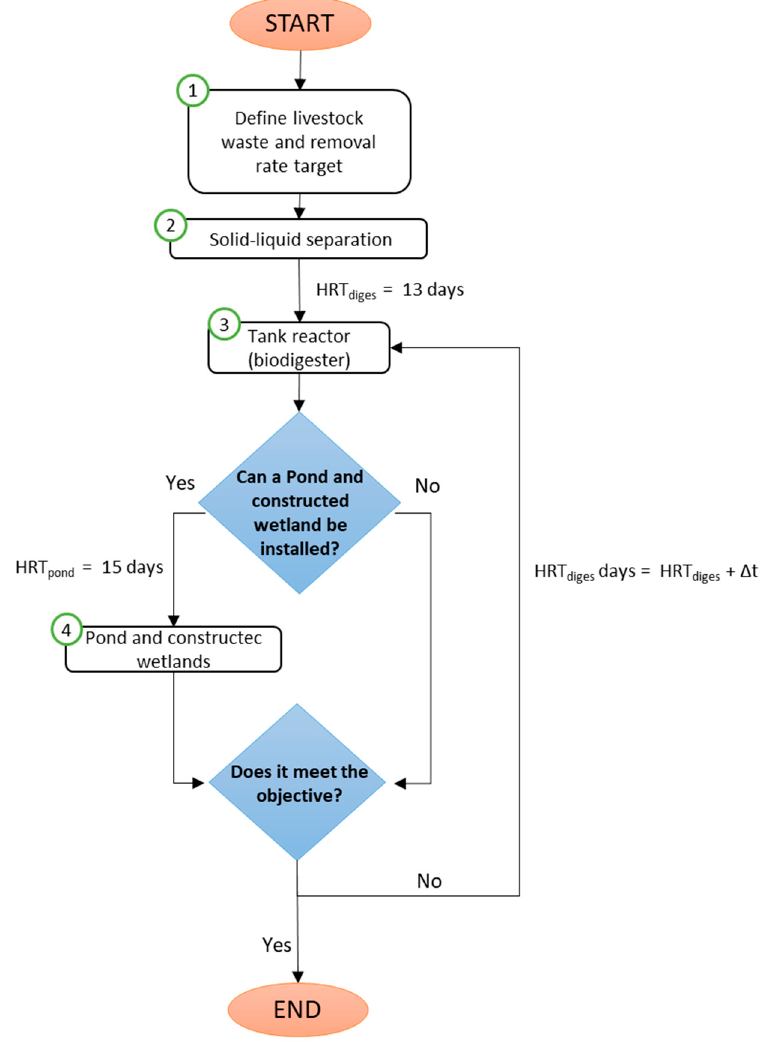
Figure 3. Flow diagram tool for NTSW design.